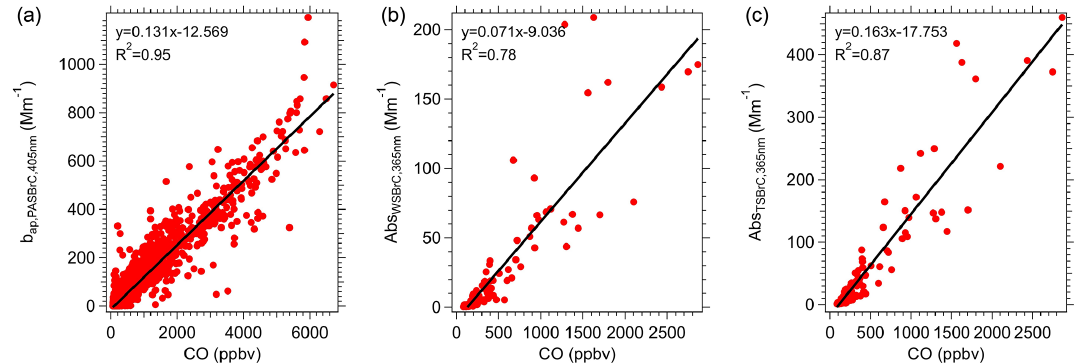
Figure 2. BrC emission ratios (ER) determined from the slope of BrC absorption to CO for the studied fires when the smoke transport time was less than 2h. Slopes are from orthogonal distance regression (ODR) of the data. Plot (a) is for PAS data at 405nm and (b) WS BrC (Abs LWCC ) and (c) TS BrC (Abs LWCC ) both at 365nm. WS BrC and TS BrC ERs are for chromophores in the solvent and have not WS , 365nm TS , 365nm been converted to aerosol absorption coefficients (see Fig. 5 for conversion factor).